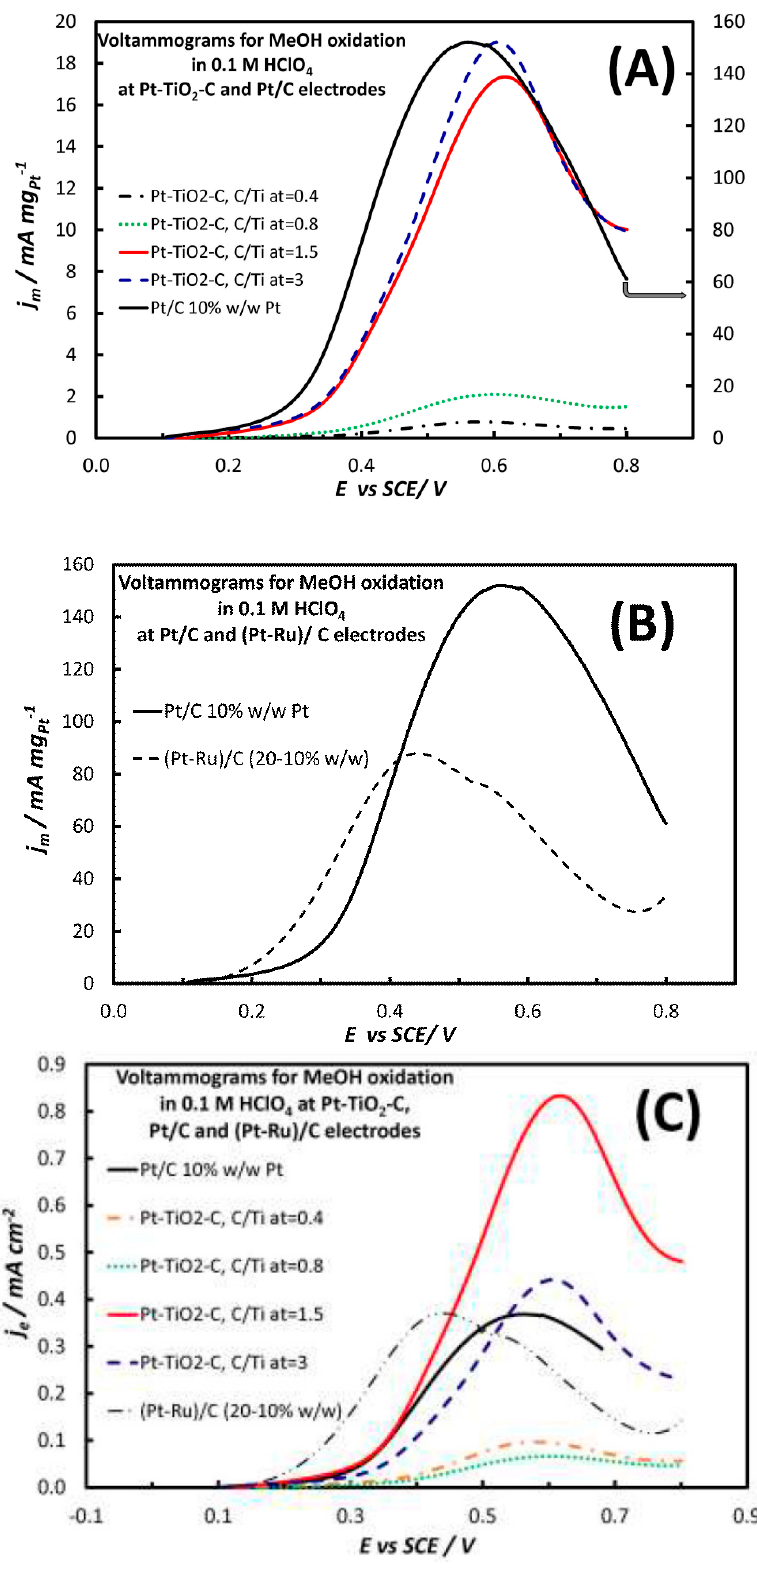
Figure 4. Linear Sweep Voltamograms, LSVs, recorded in 0.1 M HClO 4 + 0.5 M MeOH solutions at a 5 mV s − 1 potential sweep rate (to higher potentials) at Pt-TiO 2 -C (5.5–7.6% Pt w / w) electrodes and commercial Pt / C (10% Pt w / w) and (Pt-Ru) / C (20% Pt-10% Ru w / w) electrodes. Current densities are ( A , B ) per mg of Pt, j m and ( C ) per Pt EASA, j e .